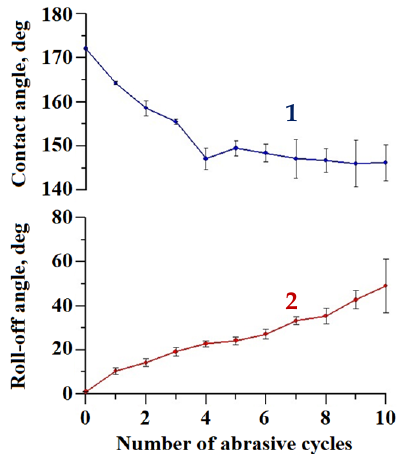
Figure 6. The variation of contact (1) and roll-off (2) angles with a number of falling sand abrasive cycles for the superhydrophobic coating on the tungsten surface obtained by regime 13.